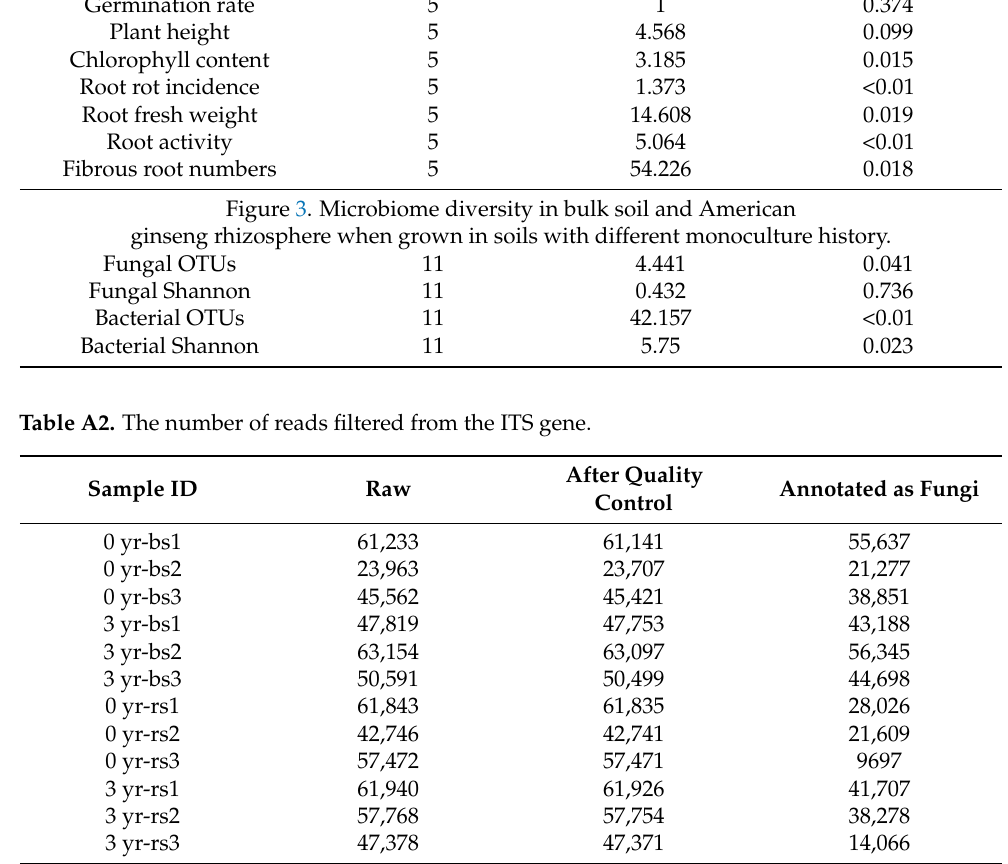
Figure 2. The effect of soil with different monoculture history on the growth of American ginseng.